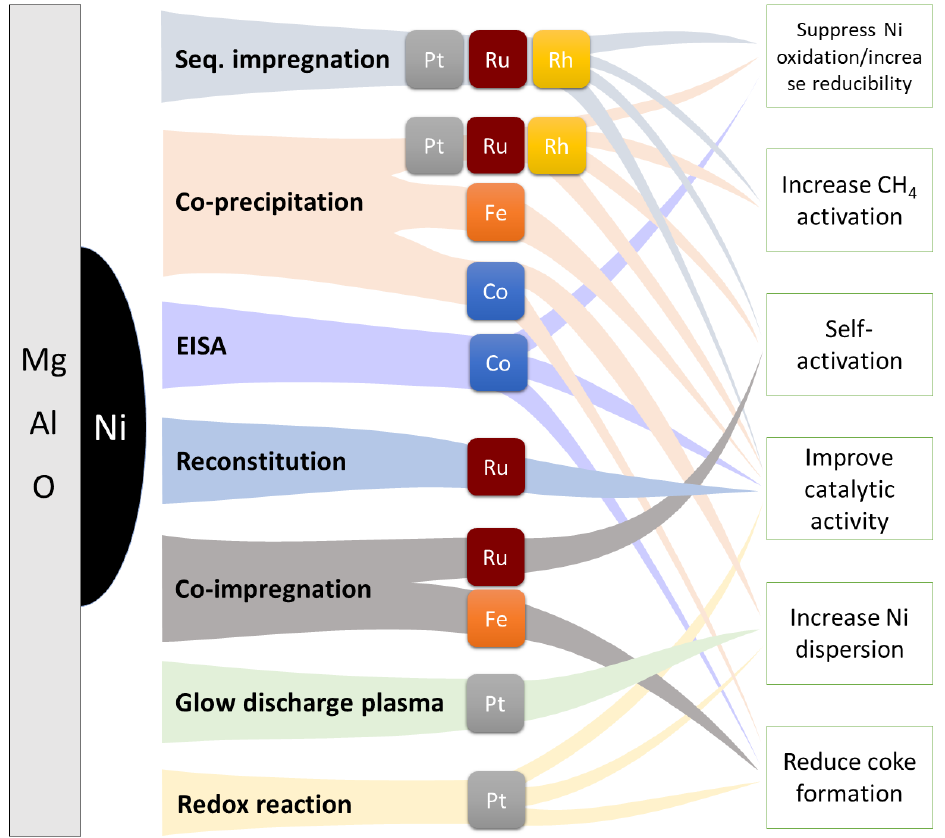
Figure 10. Schematic depiction of the main strategies adopted to enhance the catalytic activity of Ni-M/Mg(Al)O catalysts for SMR and DRM applications.